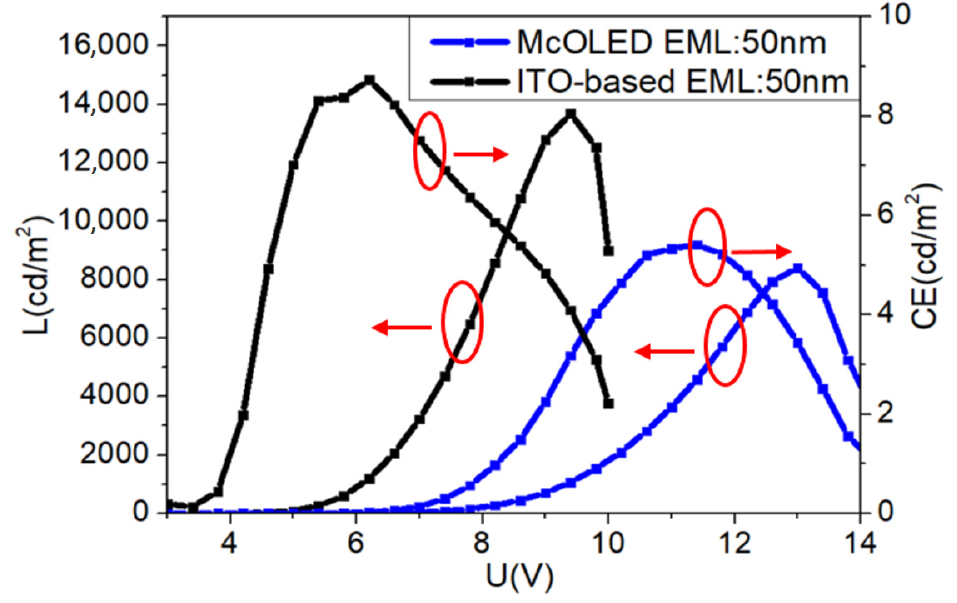
Figure 9. Current density-voltage-luminance of the ITO-based OLED and micro-cavity OLEDs.